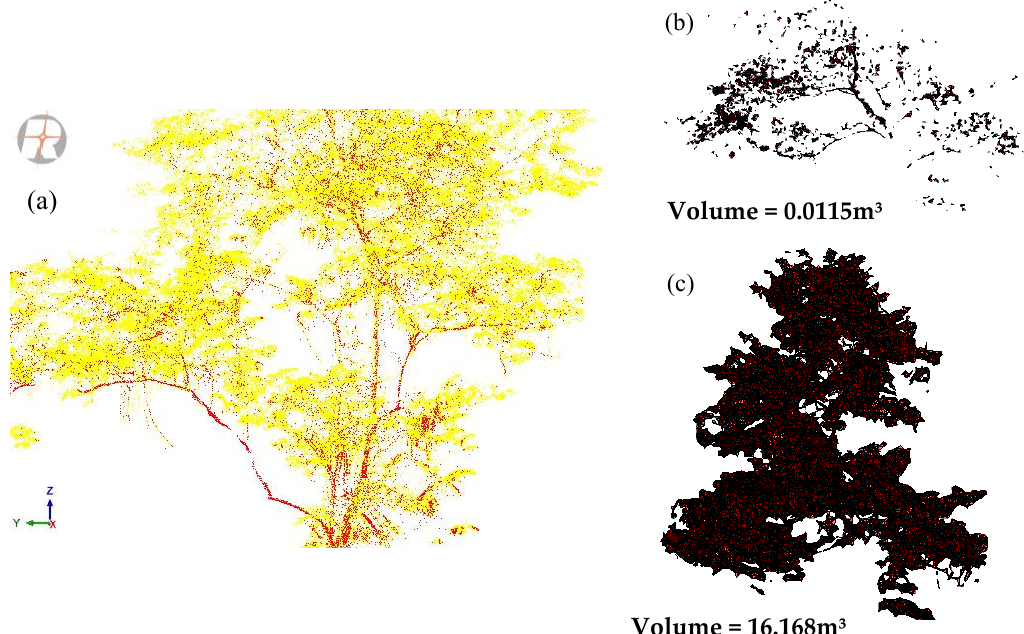
Figure 8. Delineation of branches and leaves from TLS-generated cloud points: ( a ) classified branches in red and leaves in yellow; ( b ) volume of branches and ( c ) volume of leaves, estimated using alpha shapes.